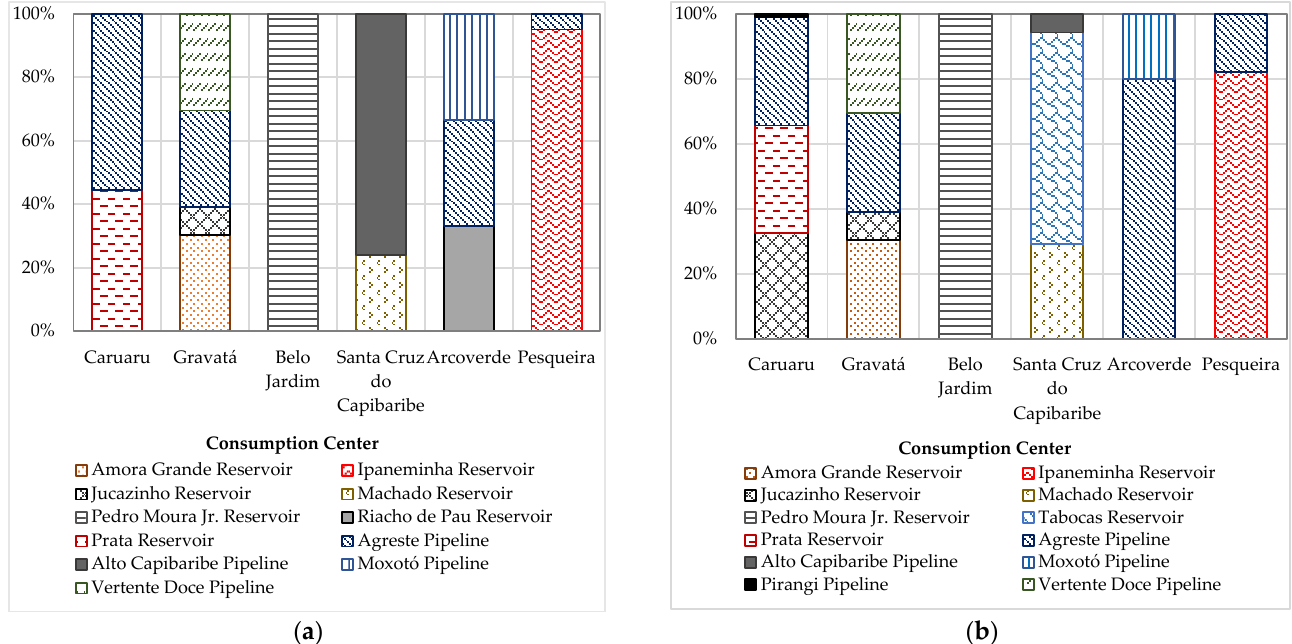
Figure 6. Distribution of flows to the consumption centers with the highest demand in the months of ( a ) February and ( b ) July.